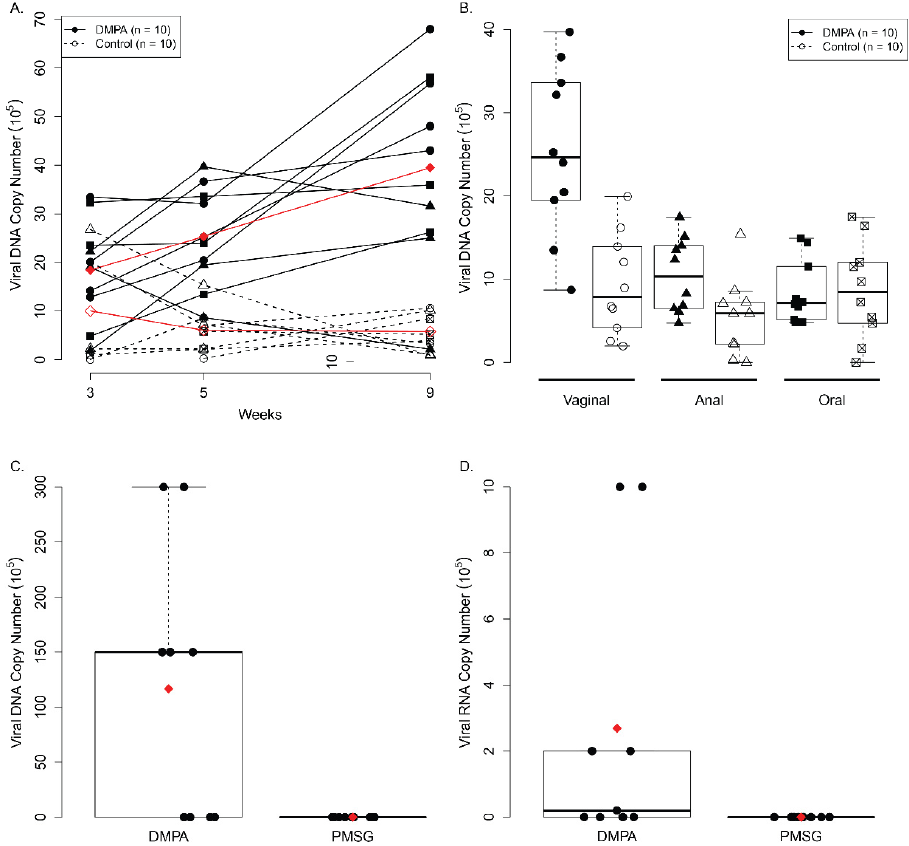
Figure 2. Increased viral load was detected in the lower genital tract and vaginal tissues of Depo medroxyprogesterone (DMPA) treated Nu/J heterozygous (Foxn1 nu/+ ) mice. Female Nu/J heterozy- gous (Foxn1 nu/+ ) were distributed into two groups ( n = 10) and treated with DMPA or pregnant mare’s serum gonadotropin (PMSG) three days before viral infections at vaginal and anal tracts. Viral DNA was detected by collecting lavage samples from the vaginal tract, the anal tract, and the oral cavity followed by qPCR analysis at different time points post-infection. Significantly higher viral DNA copies were found at vaginal ( A ) but not in anal and secondary oral infected sites in the DMPA treated group when compared with the PMSG treated group up to week nine post infection ( p < 0.05, Wilcoxon rank sum tests). Significantly higher levels of viral DNA copies were detected in DMPA treated mice while no viral DNA signal was detected in PMSG treated mice ( B ). Viral DNA ( C ) and RNA ( D ) were significantly higher in the infected vaginal tissues of mice treated with DMPA when compared with PMSG ( p < 0.05, Wilcoxon rank sum tests). All the infected vaginal tissues were further analyzed for histology and viral activi- ties. The infected athymic mice usually showed abundant viral DNA in the vaginal tract (Figure 3A, 20×). No positive viral DNA signals were found in infected heterozygous NU/J Foxn1 nu/+ mice treated with PMSG (Figure 3B, 20×) but can be detected in the vaginal tract of mice treated with DMPA (Figure 3C, 40×). The infected heterozygous NU/J Foxn1 nu/+ mice treated with DMPA were also positive for protein E4 (Figure 3D, 20×) and some L1 protein (Figure 3E, 20×, arrows) suggesting that productive infections occurred in these mice. Mild dysplasia was detected in the infected vaginal tissues (Figure 3F, 40×).